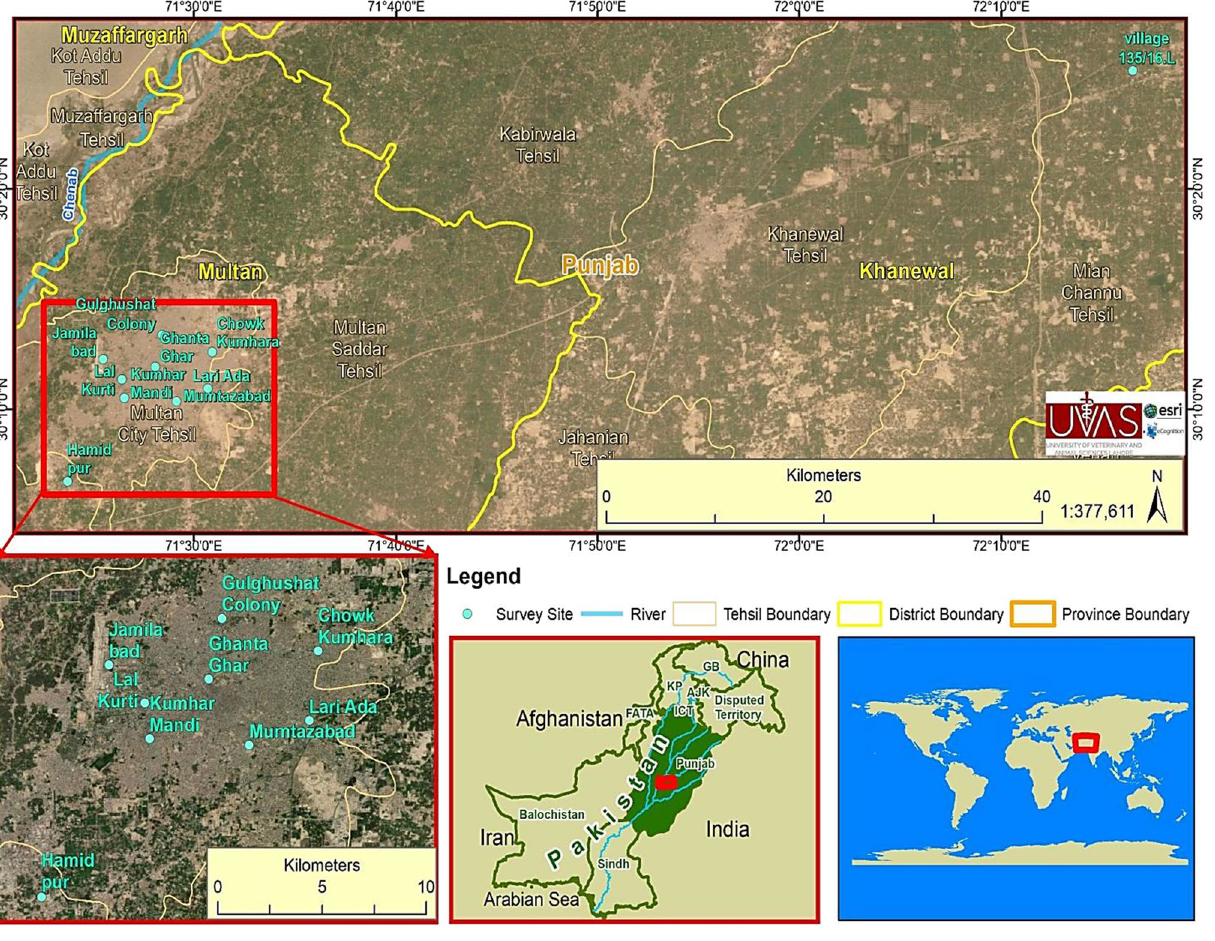
Fig. 1 Location map of study area and sampling